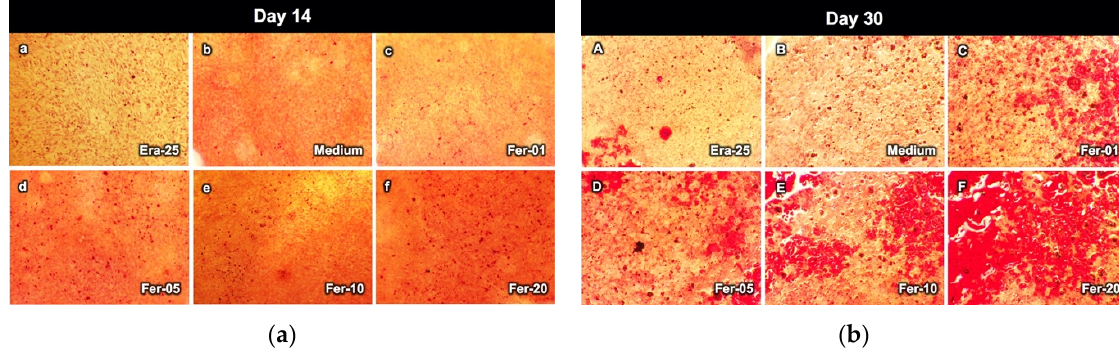
Figure 8. The bone nodule formation of MC3T3-E1 cells after exposure to Era-25, medium, Fer-01, Fer-05, Fer-10, and Fer-20: ( a ) after the 14 days differentiation and ( b ) after the 30 days differentiation.